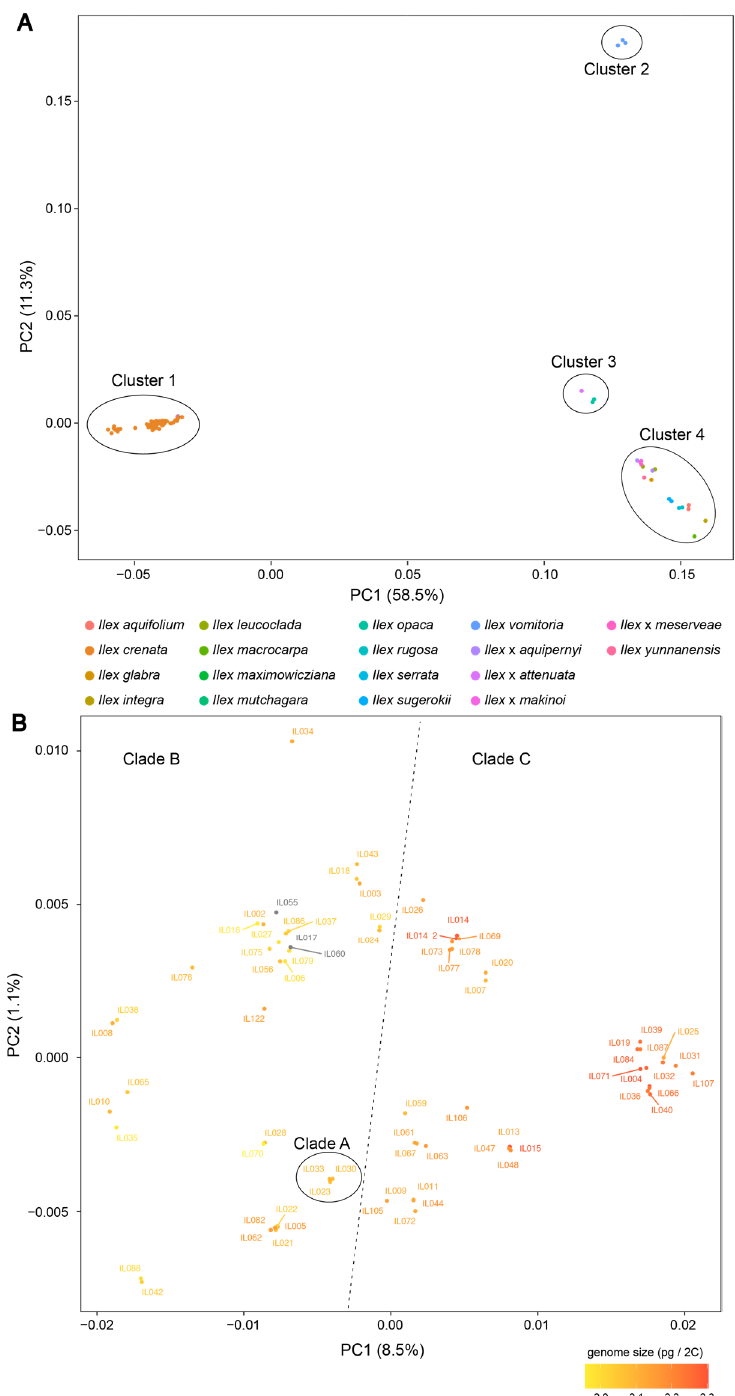
Figure 2. PCoA of the 94 accessions of the Ilex collection ( A ) and the subset of 72 I. crenata accessions ( B ). ( A ) Samples are colored by species and grouped in four clusters. ( B ) Samples are false-colored according to their genome size (range 1.98–2.30 pg/2C), while the polyploids are pictured in gray. Accessions of Clade A are grouped using a circle. The dotted line separates accessions of Clade B and Clade C.